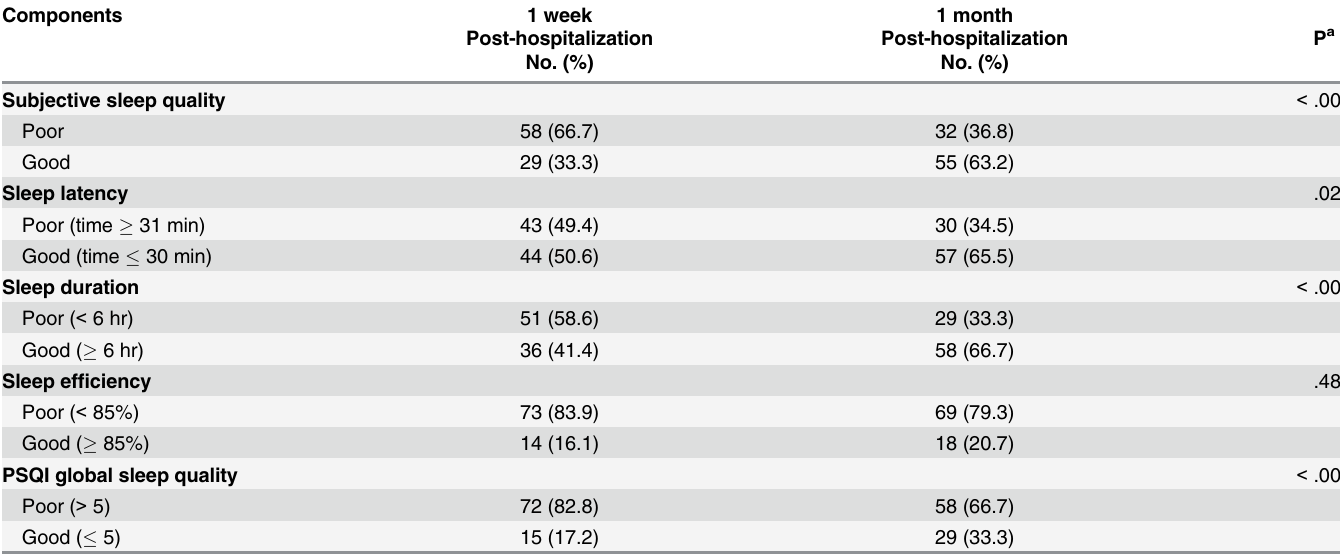
Table 3. Percent of participants with poor and good sleep quality post-hospitalization.